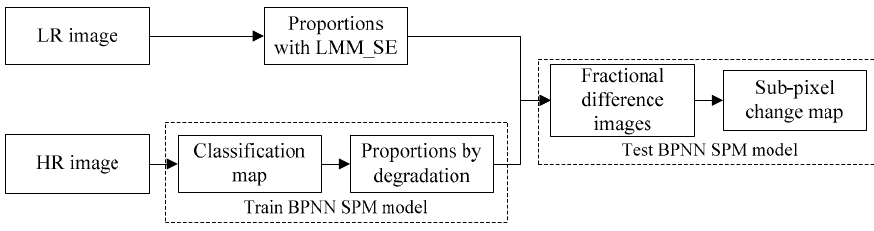
Figure 4. Diagram of the proposed BPNN_DR approach.